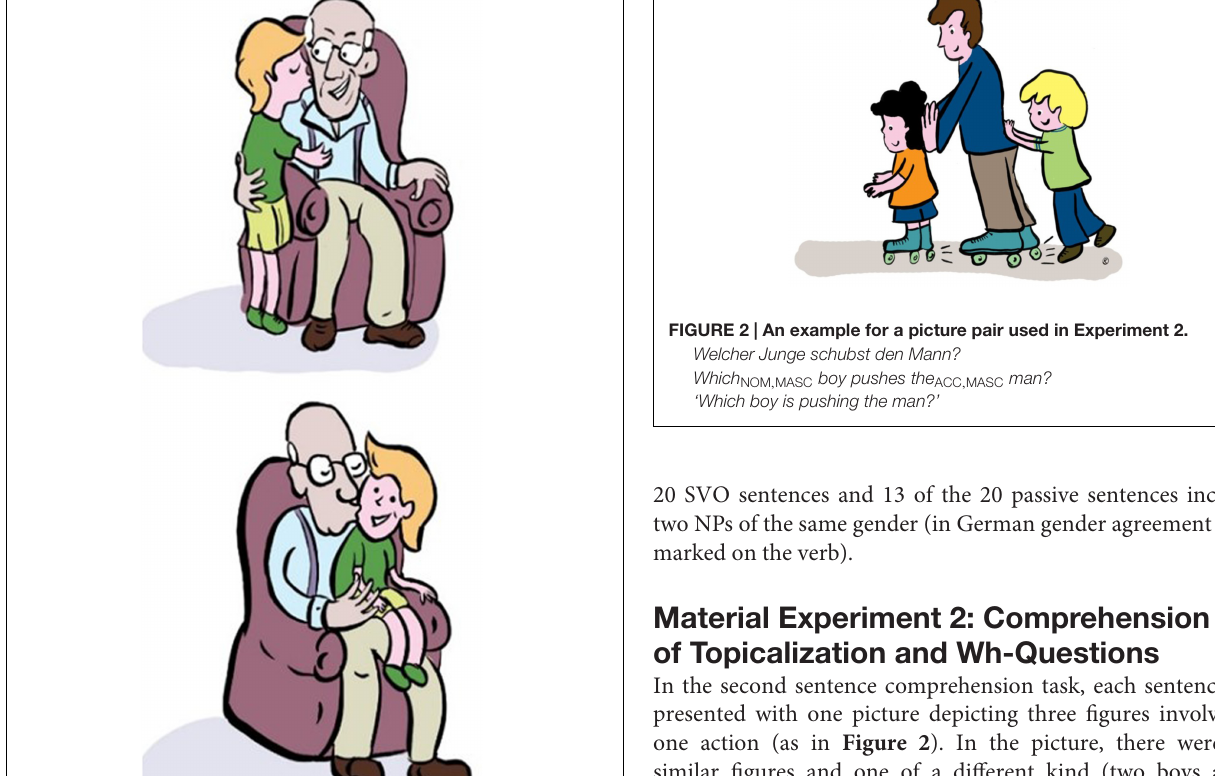
For relative clauses, both NPs were masculine, in order to make them unambiguously case-marked (see above). For simple SVO and the passive sentences we used NPs of all three grammatical genders: masculine, feminine, and neutral; 13 of the